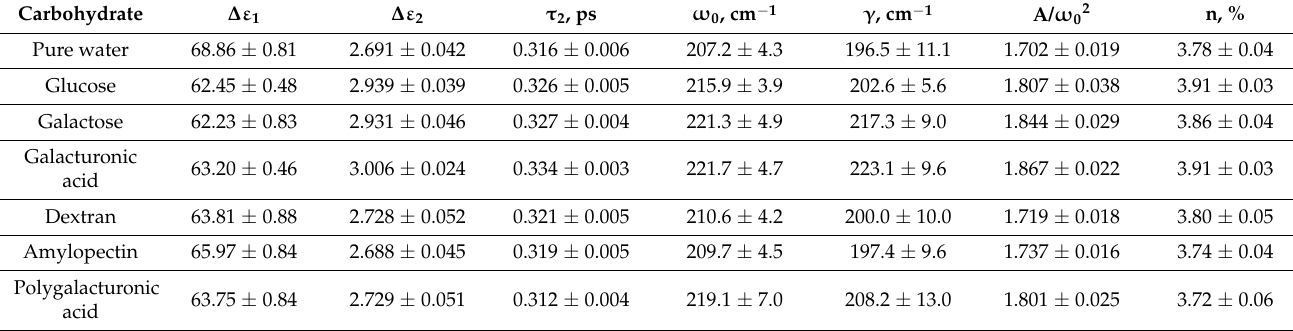
Table 1. Parameters of model DP (Equation (5)) calculated for all the studied aqueous carbohydrate solutions and pure water. Percentage of free water molecules n calculated by formula (7) is also given in the last column.